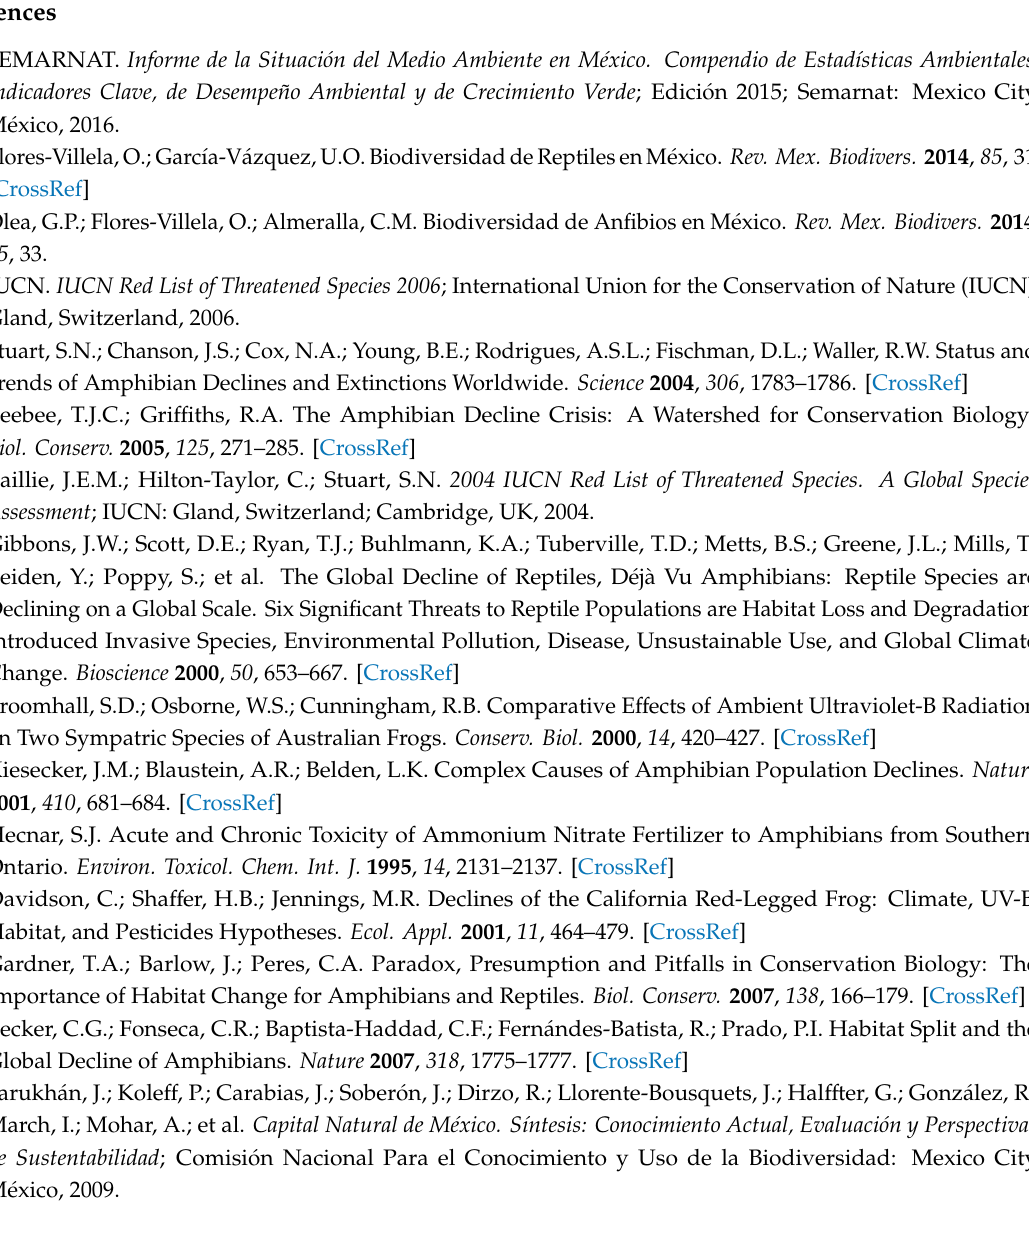
Table S1: Percentage of distribution lost caused by the impact of habitat loss and habitat loss and mining activities for the Mexican endemic species of amphibians and